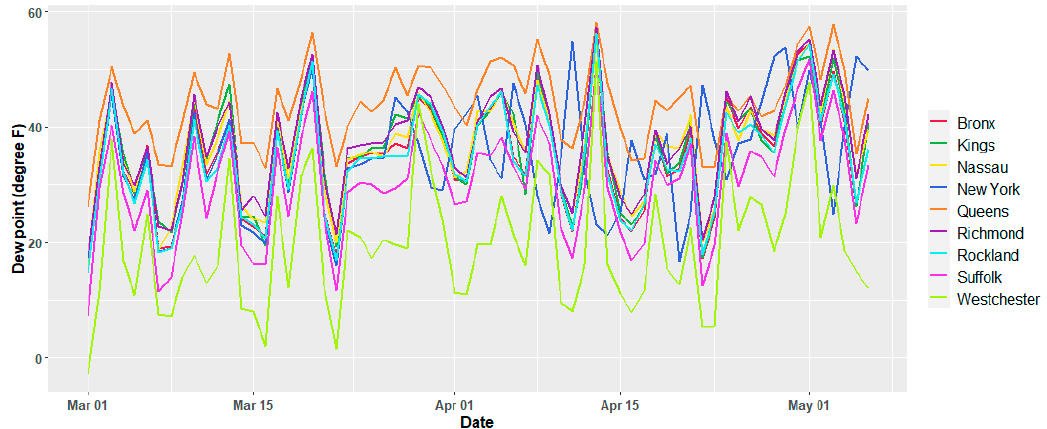
Figure 2. Variation of daily average dew point for individual counties.